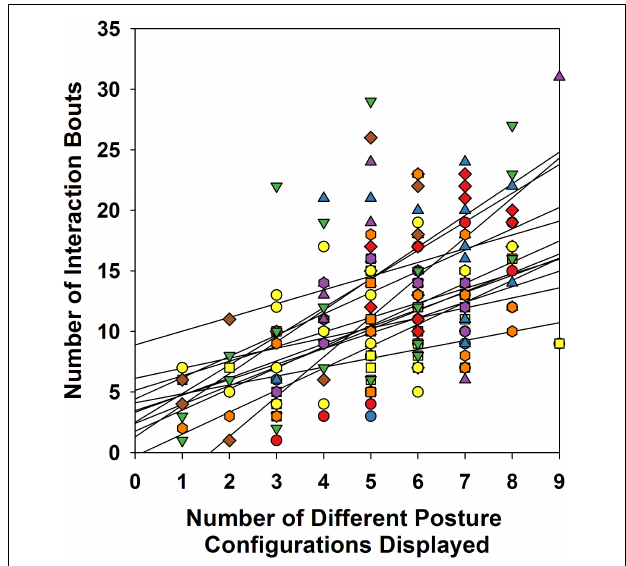
FIGURE 4 | Pearson correlations and corresponding regression lines for each of the 13 infants, fitting the relation between the number of posture categories and frequency of targeted behaviors they displayed at each session. Each symbol type represents a different infant. Note that several symbols can line up over a same number of postural configurations. This occurs when infants produce identical numbers of postural configurations across several sessions, however, each with a different number of targeted